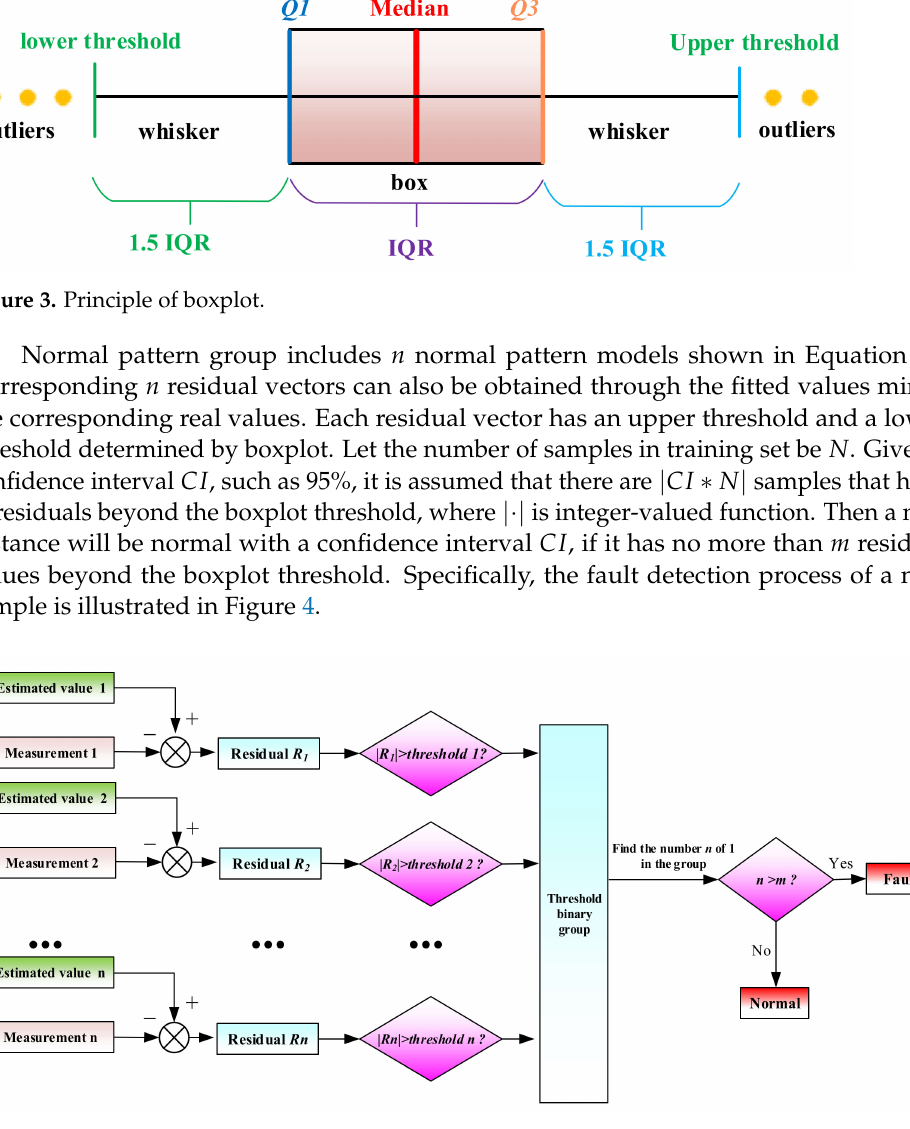
Figure 4. Collaborative decision-making strategy for fault